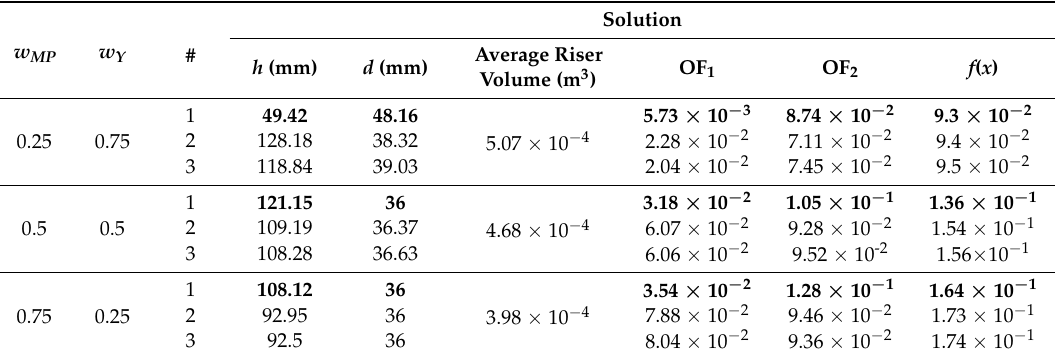
Table 2. Optimisation